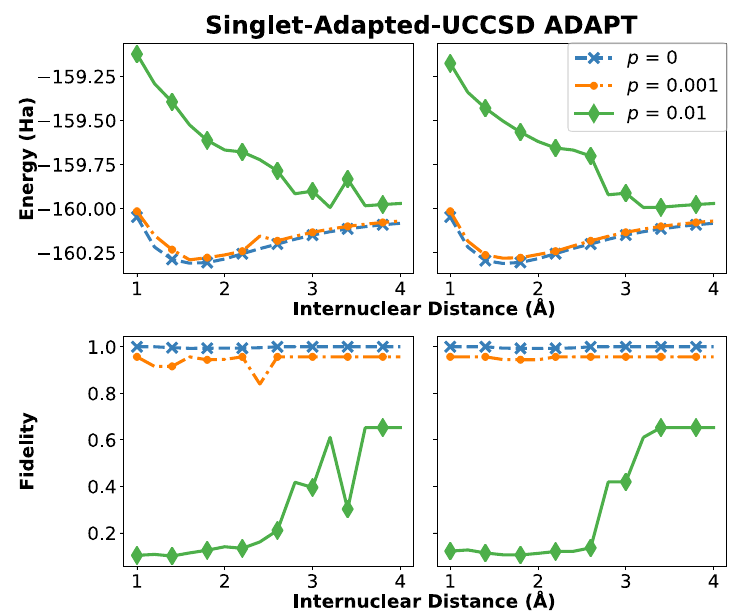
decreasing fidelity is still seen in this plot, however, with increasing depolarizing noise, the shape of the energy plot deviates from standard potential enegy curves. Likewise, the fidelity of the state prepared is not flat across all R . The increase in energy from the noiseless simulation is no greater than 1.0 Ha, while the fidelity drops at most a little less than 90% at the greatest value of noise. In contrast to the previous ansatze, the ADAPT- VQE ansatze grow uniquely with respect to R . This growth can be shown by plotting the